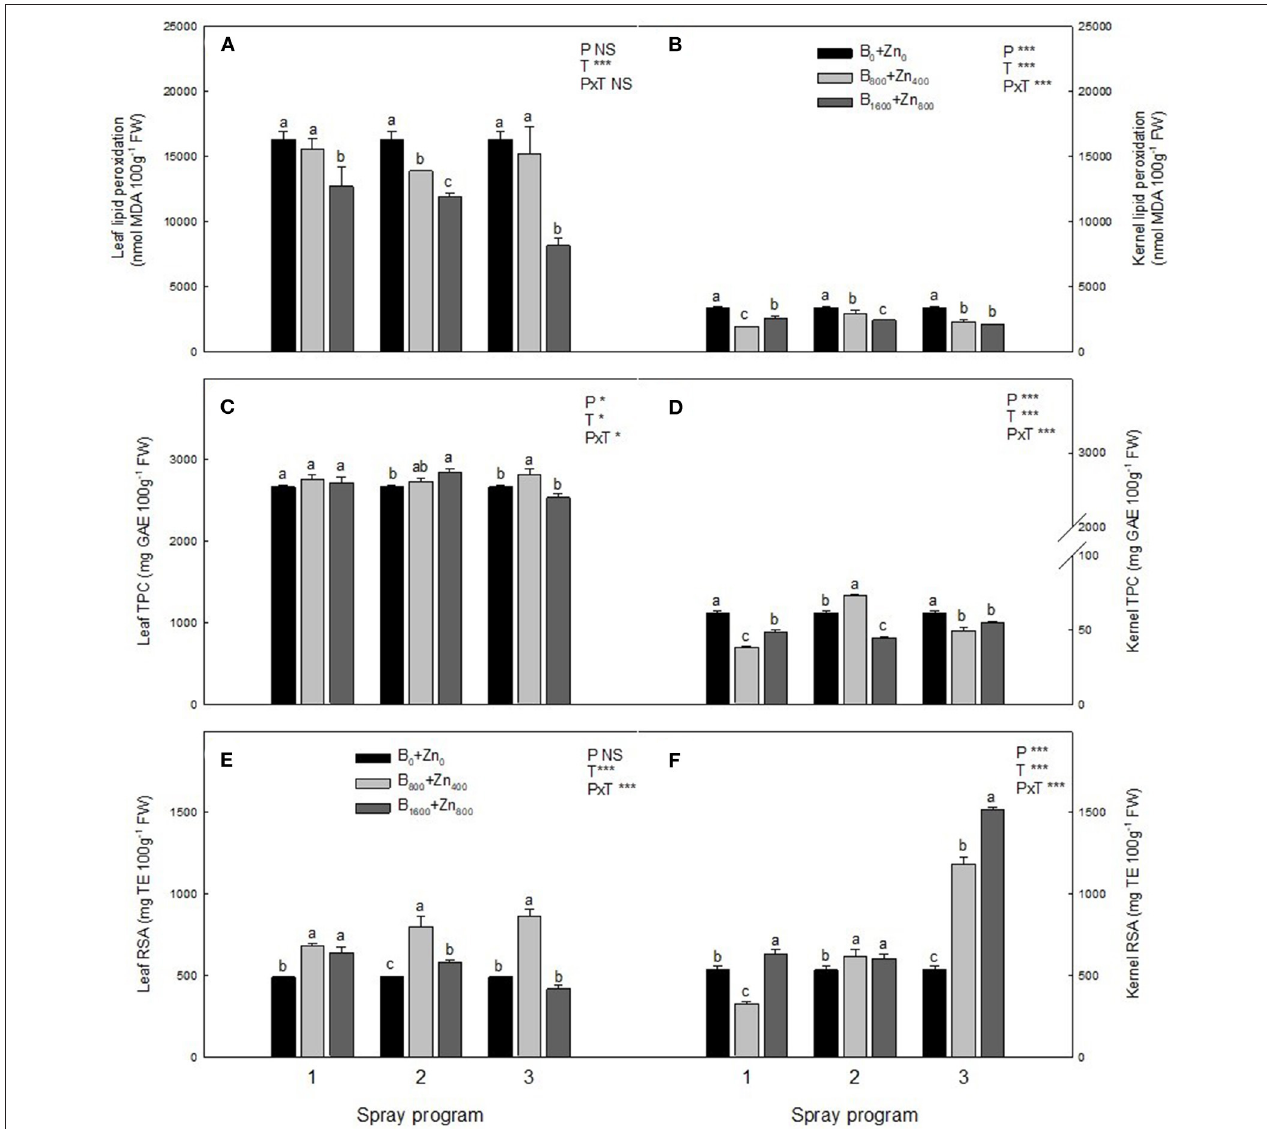
FIGURE 5 | Effects of applied spraying programs on level of malondialdehyde (MDA), phenols content (TPC), and radical scavenging activity (RSA) in leaves (A,C,E) and kernels (B,D,F) of hazelnut cultivar TDG. Values represent the mean ( n = 3) ± SE. Different lowercase letters indicate statistically significant differences ( P ≤ 0.05) among treatments within each spray program. Two-way ANOVA results are shown (NS, not significant, P > 0.05; * P < 0.05; *** P <